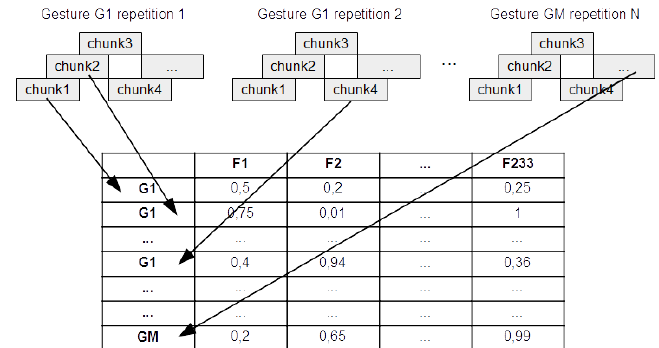
Fig. 2. Reference database creation: M gesture are recorded, each one repeated N times. Overlapping sliding windows of 60 frames cut gestures in chunks. Two hundred thirty three motion features are computed for each gesture chunk and recorded as a line of the database, together with the class name the gesture belongs